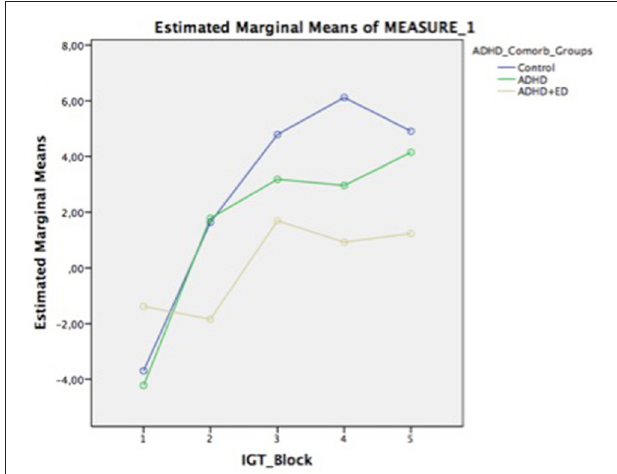
FIGURE 1 | Iowa Gambling Task across groups over